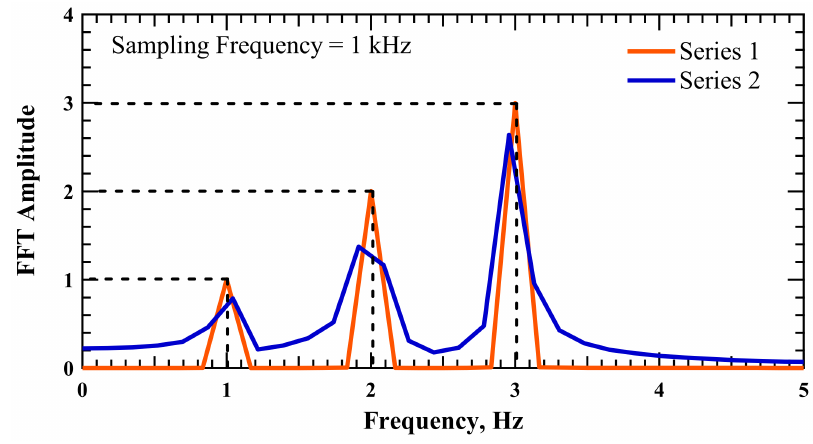
Figure 7. The FFT of Series 1 and Series 2.